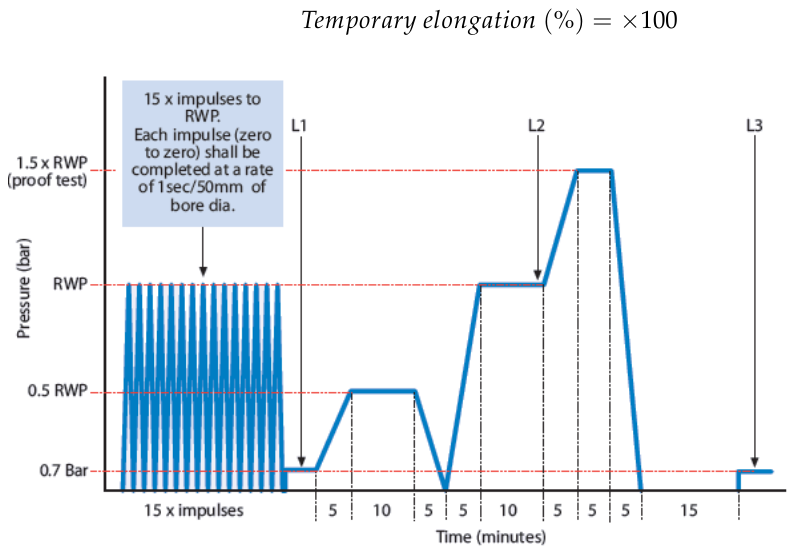
Figure 26. Depiction of hydrostatic pressure test showing applied pressures.